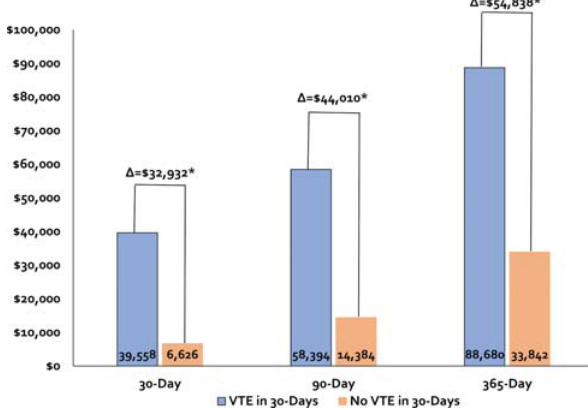
Fig. 3 Unadjusted change in 30-, 90- and 365-day costs between medically ill patients experiencing and not experiencing a venous thromboembolism in the fi rst 30-days post-index hospitalization. Δ , delta (difference in costs); VTE, venous thromboembolism. (cid:4) p <